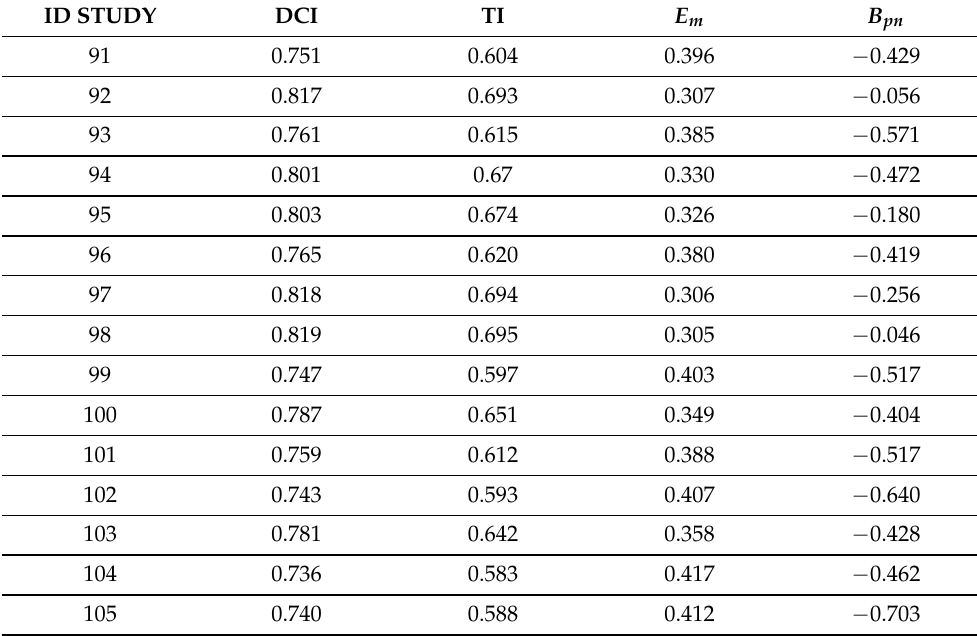
Table 1. Average of the error indices on the slices of each of the 15 patients analyzed.